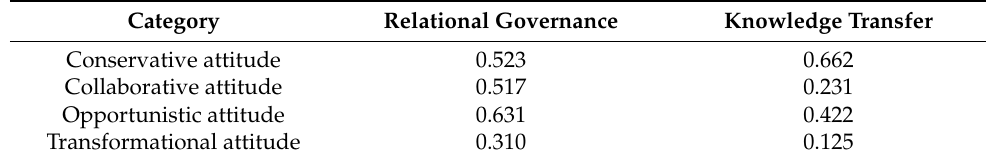
Table 7. Canonical discriminant function